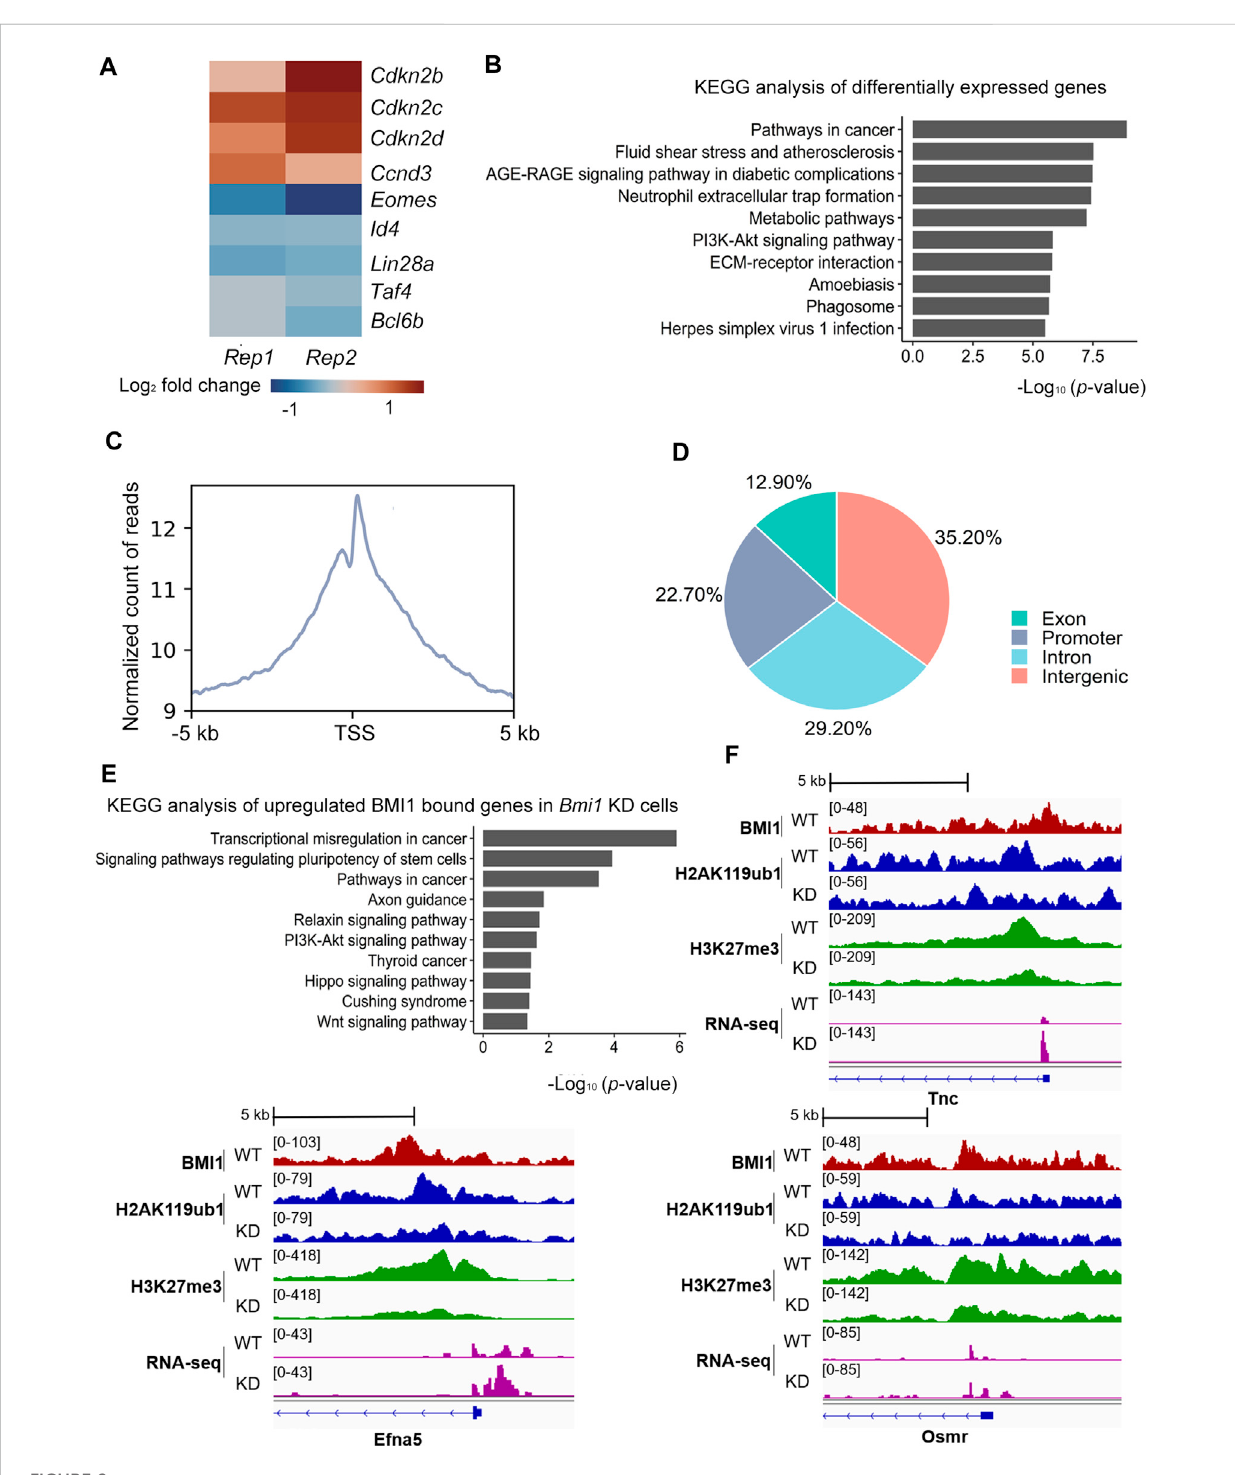
FIGURE 2 BMI1 regulates PI3K-Akt signaling pathway to maintain undifferentiated spermatogonia fate. (A) Heatmap illustrating the expression changes of selected genes related with proliferation and stemness. Results are showed as log 2 fold change in wildtypeand knockdown cells. Each lanecorresponds to an independent paired biological sample. (B) KEGG analysis of differentially expressed genes. Results are expressed as -log 10 ( p -value). (C) TSS (±5 kb) enrichment plot of BMI1 ChIP-seq at target sites. (D) Genome-wide distribution of BMI1 binding regions. (E) KEGG analysis of upregulated BMI1 bound genes in Bmi1 knockdown cells. Results are expressed as -log 10 ( p -value). (F) IGV shows the binding peaks of BMI1, H2AK119ub1 and H3K27me3 ChIP-seq results together with RNA-seq data from WT and Bmi1 KD cells at Tnc , Efna5 and Osmr